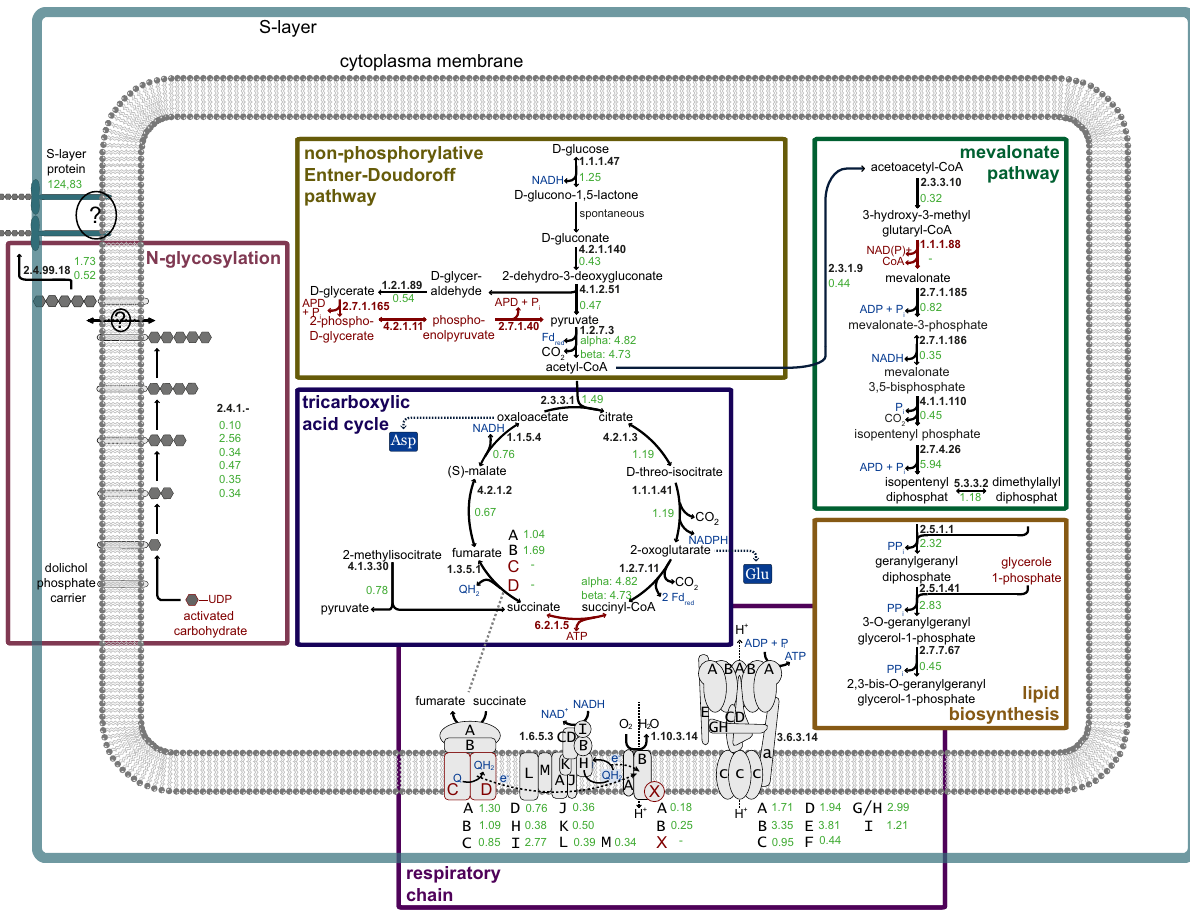
Fig. 2 Schematic overview of possible central metabolic pathways of Ca . Micrarchaeum harzensis. Given are the enzyme commission (EC) numbers of the involved enzymes in bold and the Transcripts Per Million (TPM) values (mean value of four co-culture samples) of the corresponding Ca . Micrarchaeum harzensis genes in green. Missing genes and metabolites that the Micrarchaeon cannot produce itself are highlighted in dark red. Question marks label the unknown anchoring of the S-layer protein and an unknown fl